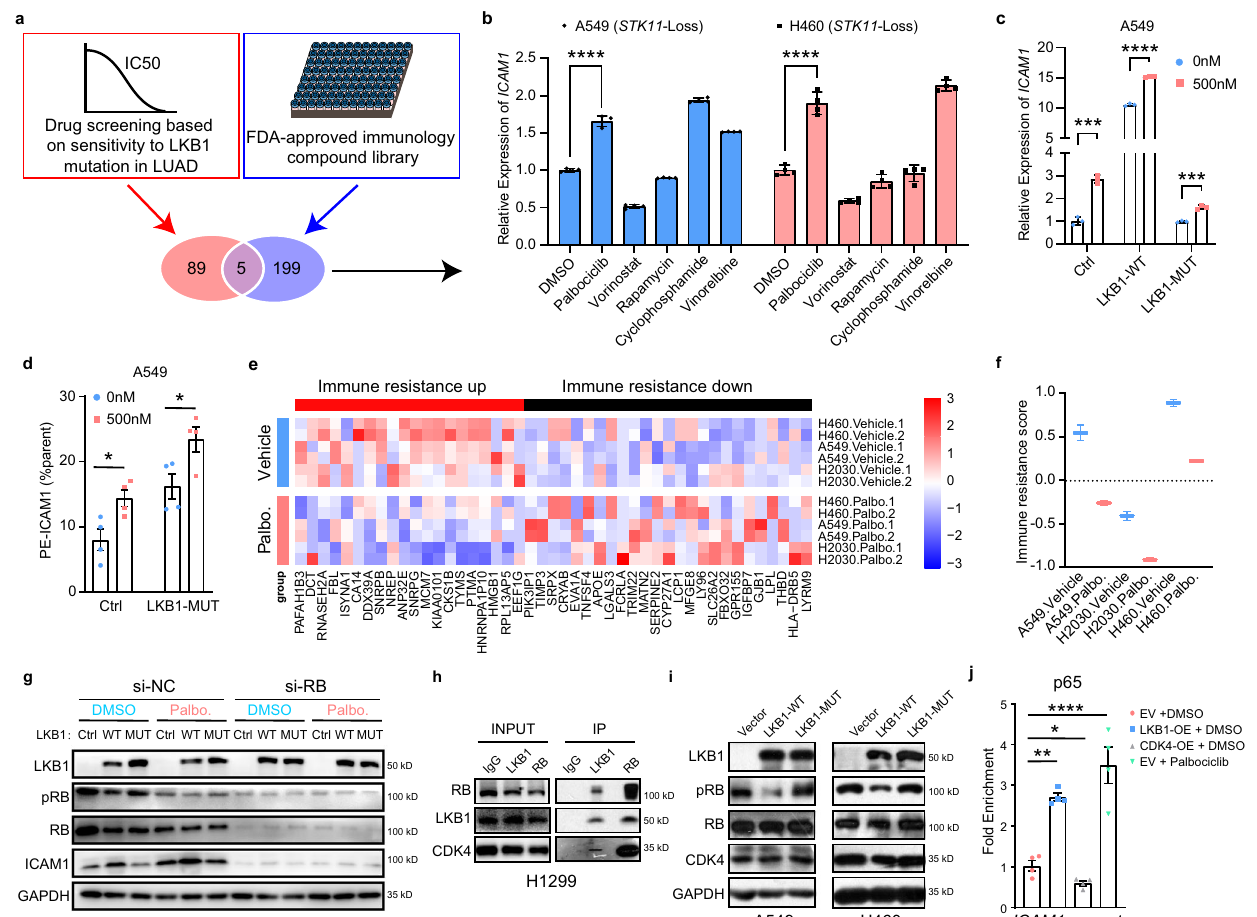
Fig. 5 | CDK4/6 inhibitors were carefully selected for LKB1 mutant lung cancer basedonthemechanisticlinkbetweenLKB1-RB-CDK4interaction.a Combined drug screening using drugs from both the Genomics of Drug Sensitivity in Cancer (GDSC) database based on sensitivity to LKB1 mutation and an FDA-approved immunology compound library. b Quantitative RT-qPCR of relative ICAM1 expres- sion in A549 and H460 cells treated with 5 selected drugs (cyclophosphamide monohydrate; vinorelbine tartrate; vorinostat; rapamycin; palbociclib). n =4 bio- logically independent samples examined over 1 independent experiment. **** p <0.0001, **** p <0.0001. A549 cells transfected with lentivirus expressing the indicated genes (LV-Ctrl, LV- LKB1 -WT, LV- LKB1 -Mut), treated ± 500nM palbociclib were harvested for quantitative RT-qPCR ( c ) and fl ow cytometry analysis ( d ). n =3 biologically independent samples examined over 1 independent experiment. *** p =0.0002, **** p <0.0001, *** p =0.007 ( c ). n =4 biologically independent sam- ples examined over 1 independent experiment. * p =0.023, * p =0.0378 ( d ). e , f Impact of CDK4/6i on LKB1 mutant lung cell line pro fi les. e Expression of immune resistance program genes (columns) that were most differentially expressed in palbociclib-treated (green) versus control (pink) cell lines (rows). Expression is normalized in each cell line. f Immune resistance scores in cell lines